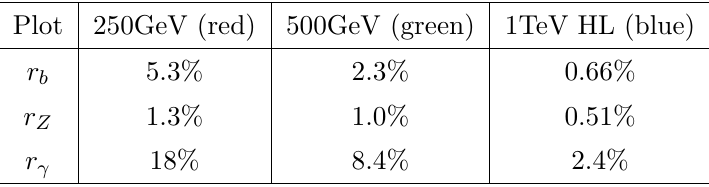
Table 1. A selection of Higgs coupling deviation exclusion bounds, as predicted in [35]. These are forecasts for ILC precision relative to the SM prediction.